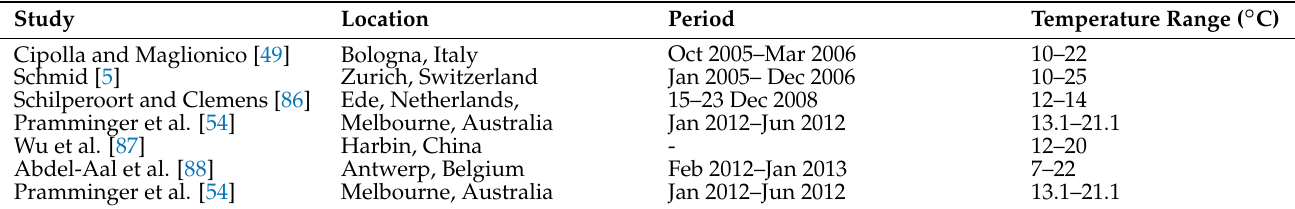
Table 4. Wastewater temperature measurement found in